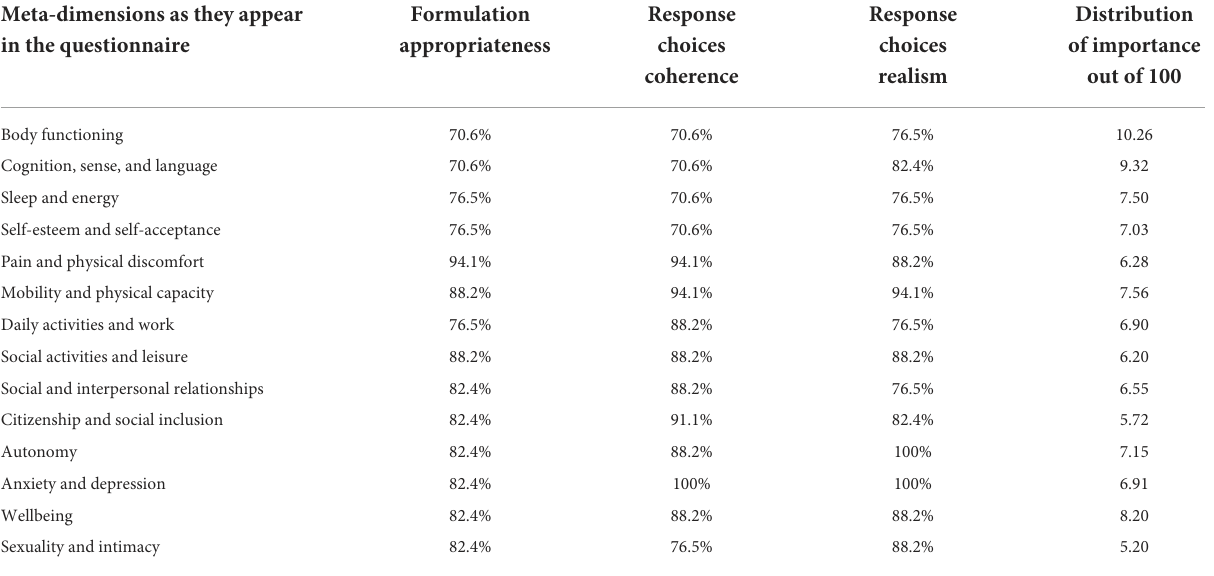
TABLE 3 Results after round 2.